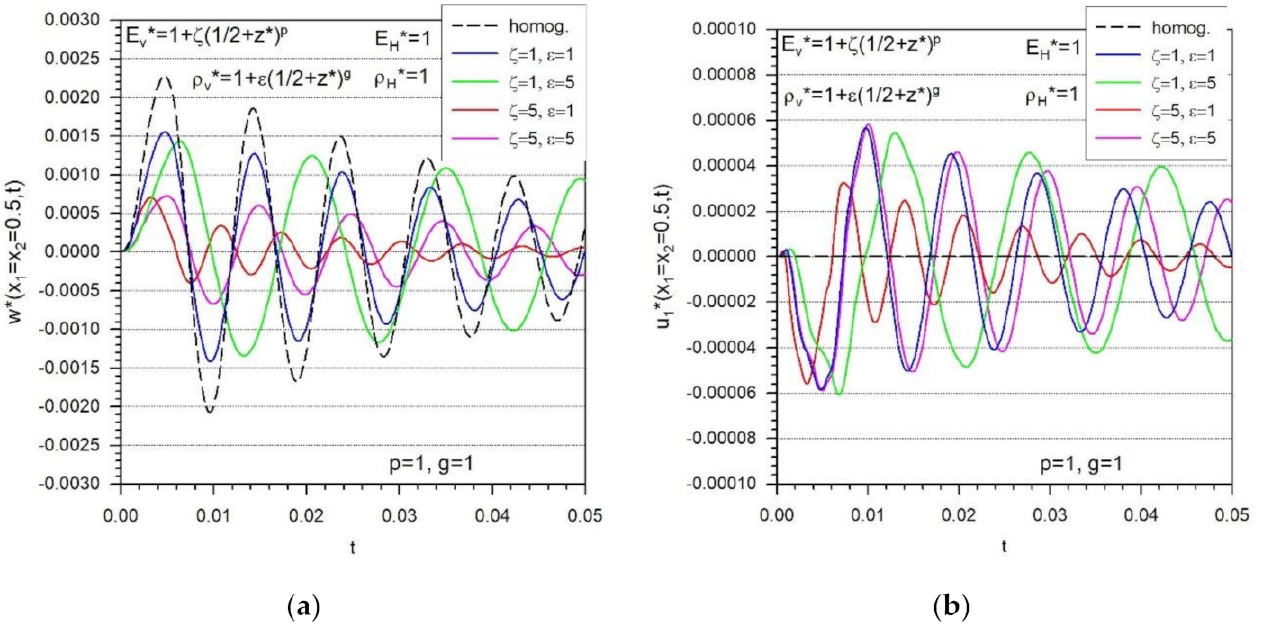
Figure 9. Effect of the level of gradation of the mass density ( ε ) and/or the elastic modulus ( ζ ) on the time variation of: ( a ) the dimensionless central deflection, ( b ) the dimensionless in-plane deformation.